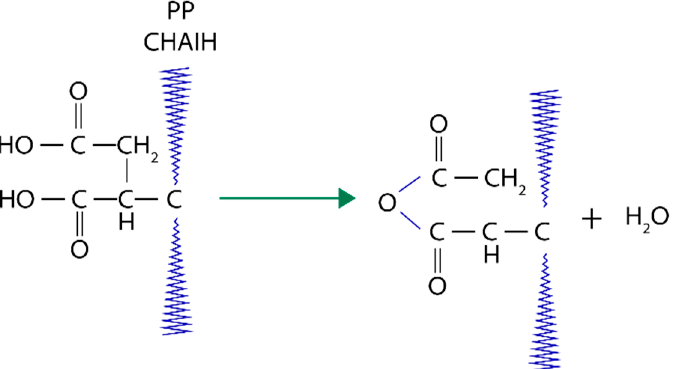
Figure 10. First method of treatment of cellulose fibers with MAPP copolymer.